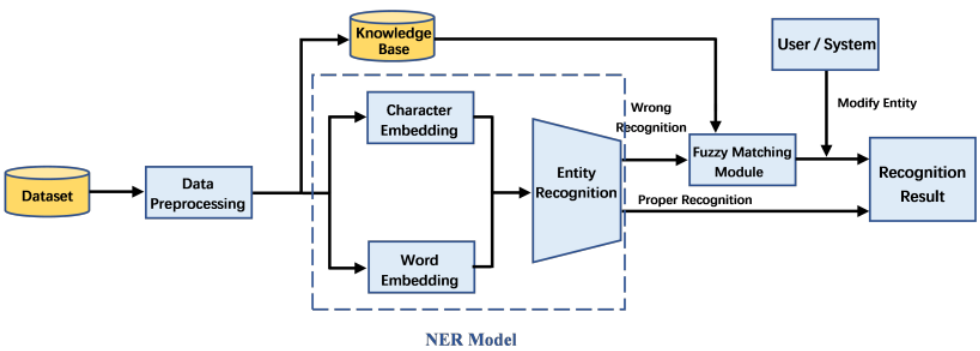
Figure 1. The overall architecture of the NER